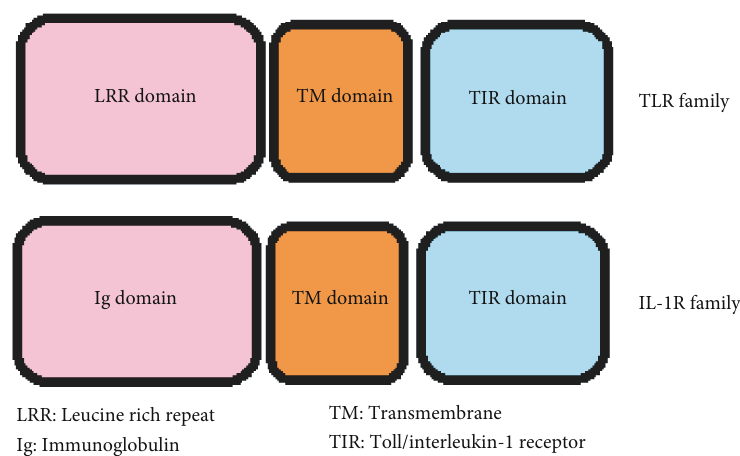
Figure 5: A comparison between TLR and IL-R families. Their di ff erence is related to the LRR and Ig